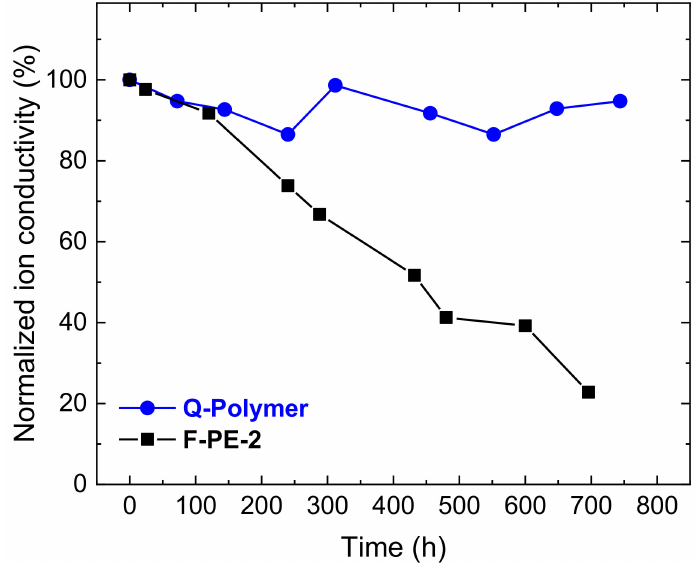
Figure 10. Normalized hydroxide ion conductivity of the Q-polymer membrane during stability testing in a 1 M NaOH solution at 25 ◦ C for 700 h, compared with the results of a poly(arylene ether) based membrane, F-PE-2. Adapted with permission from reference [19]. Copyright 2017